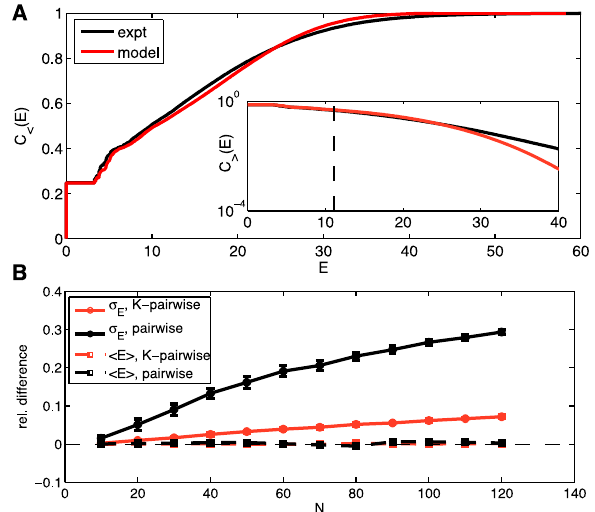
Figure 8. Predicted vs real distributions of energy, E . ( A ) The cumulative distribution of energies, C v ( E ) from Eq (22), for the K- pairwise models (red) and the data (black), in a population of 120 neurons. Inset shows the high energy tails of the distribution, C w ( E ) from Eq (24); dashed line denotes the energy that corresponds to the probability of seeing the pattern once in an experiment. See Figure S5 for an analogous plot for the pairwise model. ( B ) Relative difference in the first two moments (mean, h E i , dashed; standard deviation, q ffiffiffiffiffiffiffiffiffiffiffiffiffiffiffiffiffiffiffiffiffiffiffiffi , solid) of the distribution of energies evaluated over s E ~ h E 2 i { h E i 2 real data and a sample from the corresponding model (black=pairwise; red=K-pairwise). Error bars are s.d. over 30 subnetworks at a given size N .